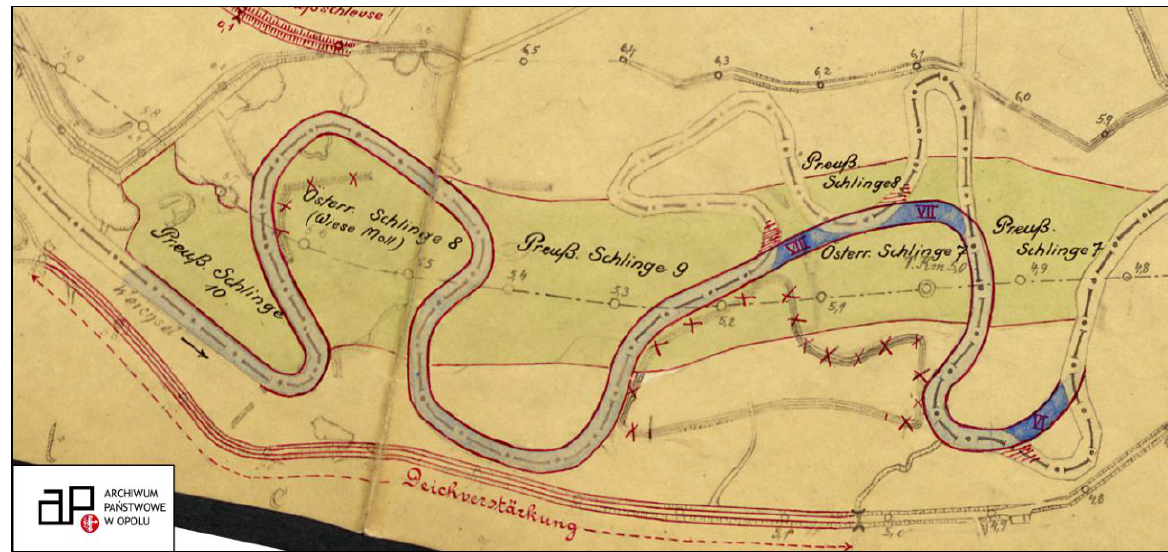
Fig. 9. River engineering work design – River Vistula valley (after Regulierung der Österreichische Weichselstrecke, 1892–